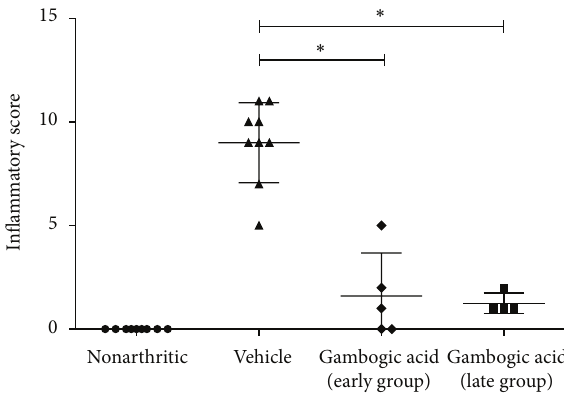
Figure 4: Gambogic acid possesses anti-inflammatory properties. Inflammatory score in gambogic acid-treated AIA rats is signif- icantly diminished in comparison with vehicle-treated rats after treatment. Differences were considered statistically significant for 𝑃 values <